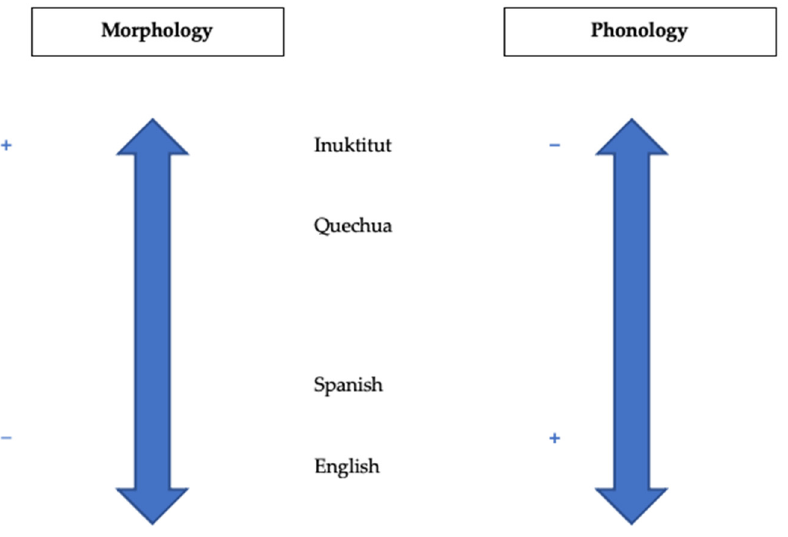
Figure 8. Schematization of the relationship between morphology, phonology, and information structure with examples from the languages mentioned in this paper.